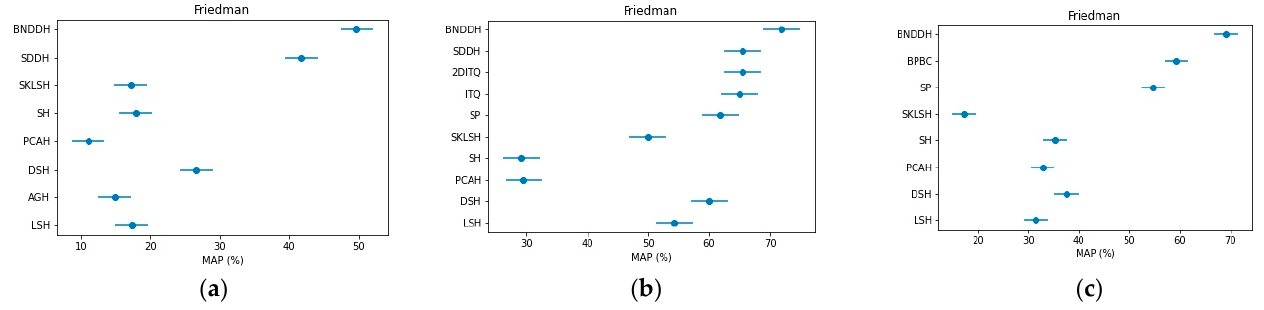
Figure 10. The Friedman test of the MAP (%) on the ( a ) CIFAR-10 database; ( b ) Yale-B database; ( c ) MNIST database.